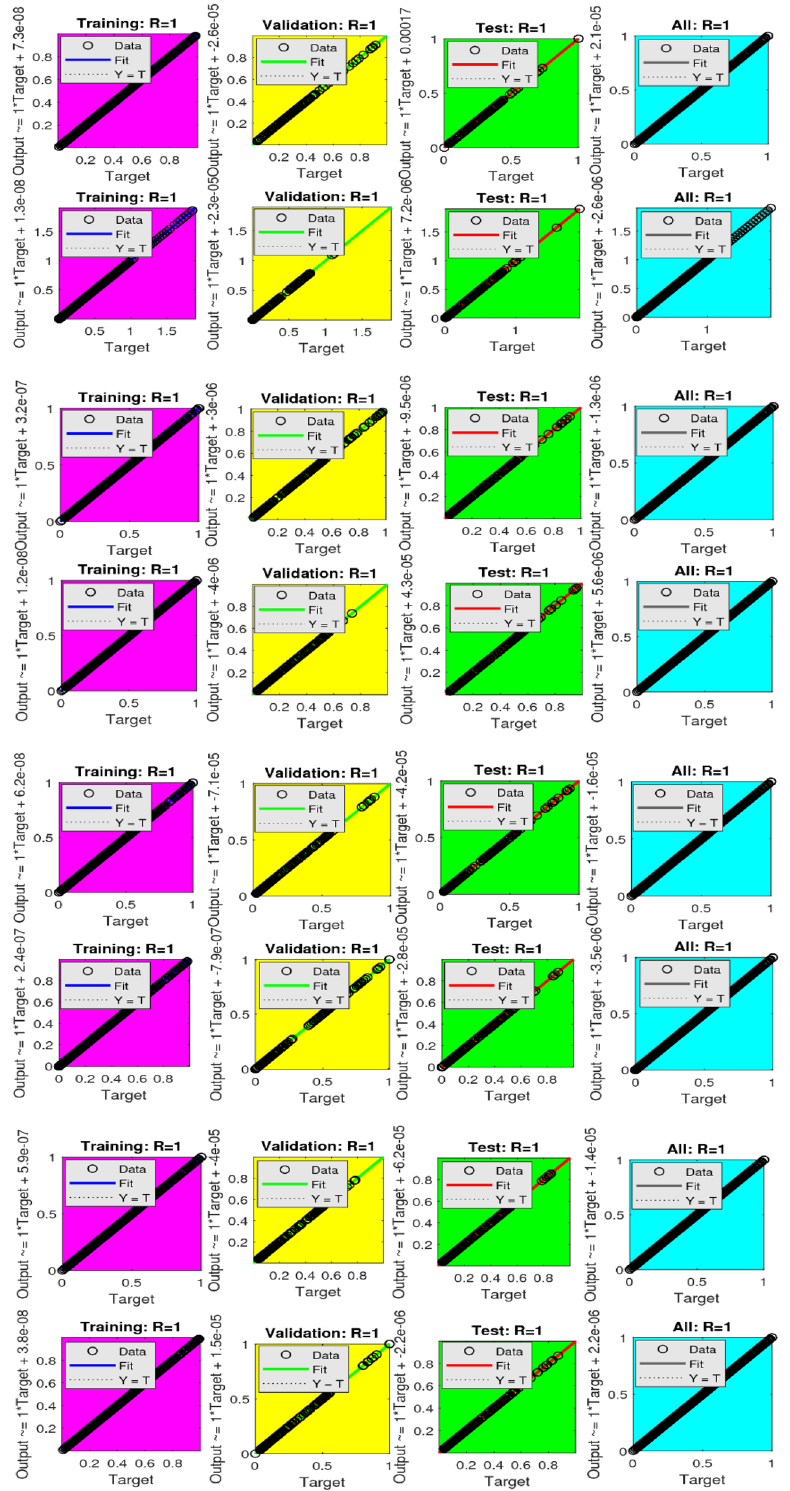
Figure 9. Illustrations via regression plots for C3 of all eight